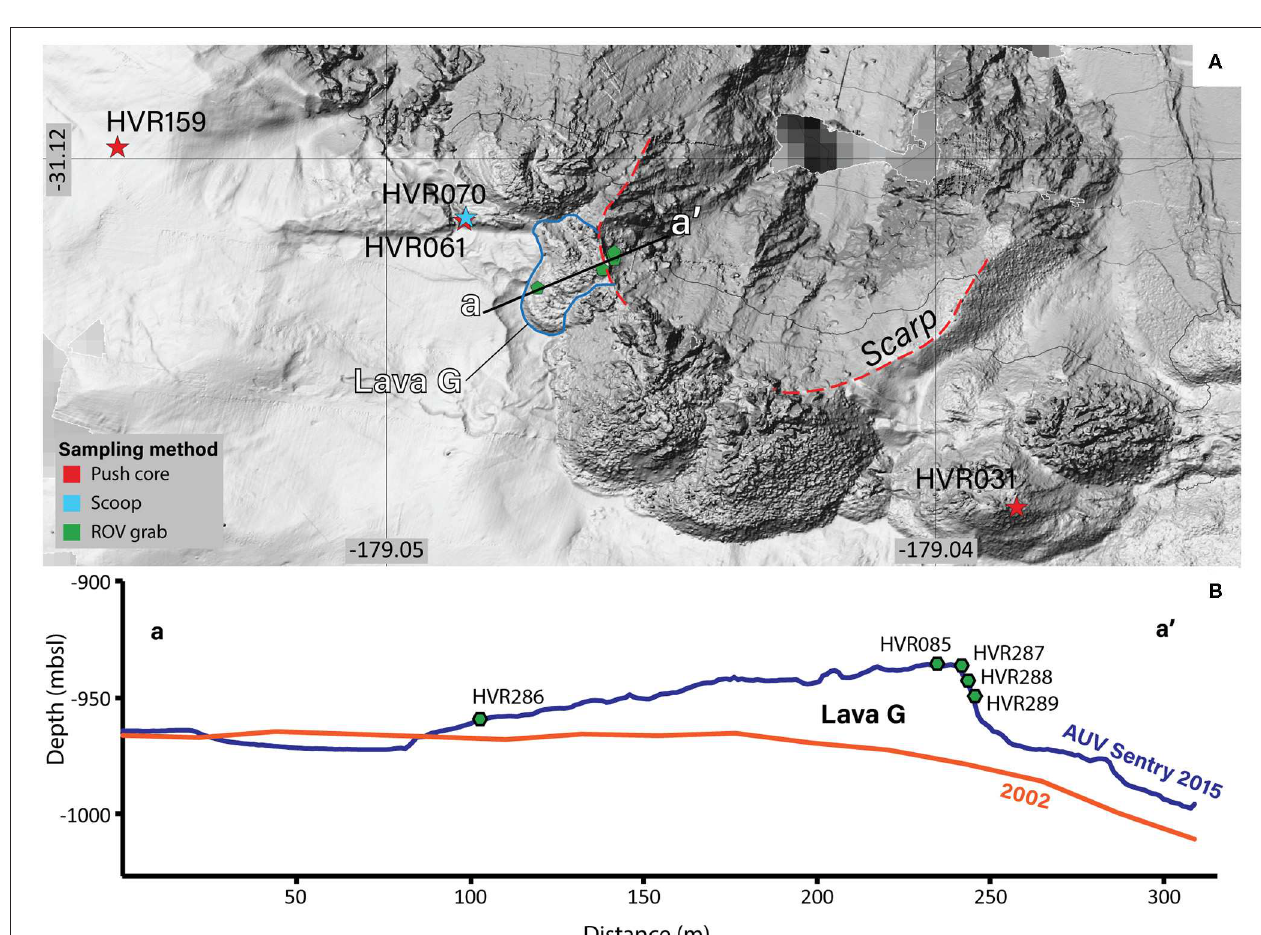
FIGURE 7 | (A) Detailed map of Lava G with locations of clastic samples (stars) and grab samples of Lava G (pentagons). Scarp cutting the northern edge of Lava G is seen as a sharp break in topography at the head of a gully in the caldera wall (red dashed line). In (B) pre-eruption (2002) and post-eruption (2015) AUV Sentry profiles through Lava G, locations indicated in (A) . Sites of Lava G samples indicated on the AUV Sentry profile.